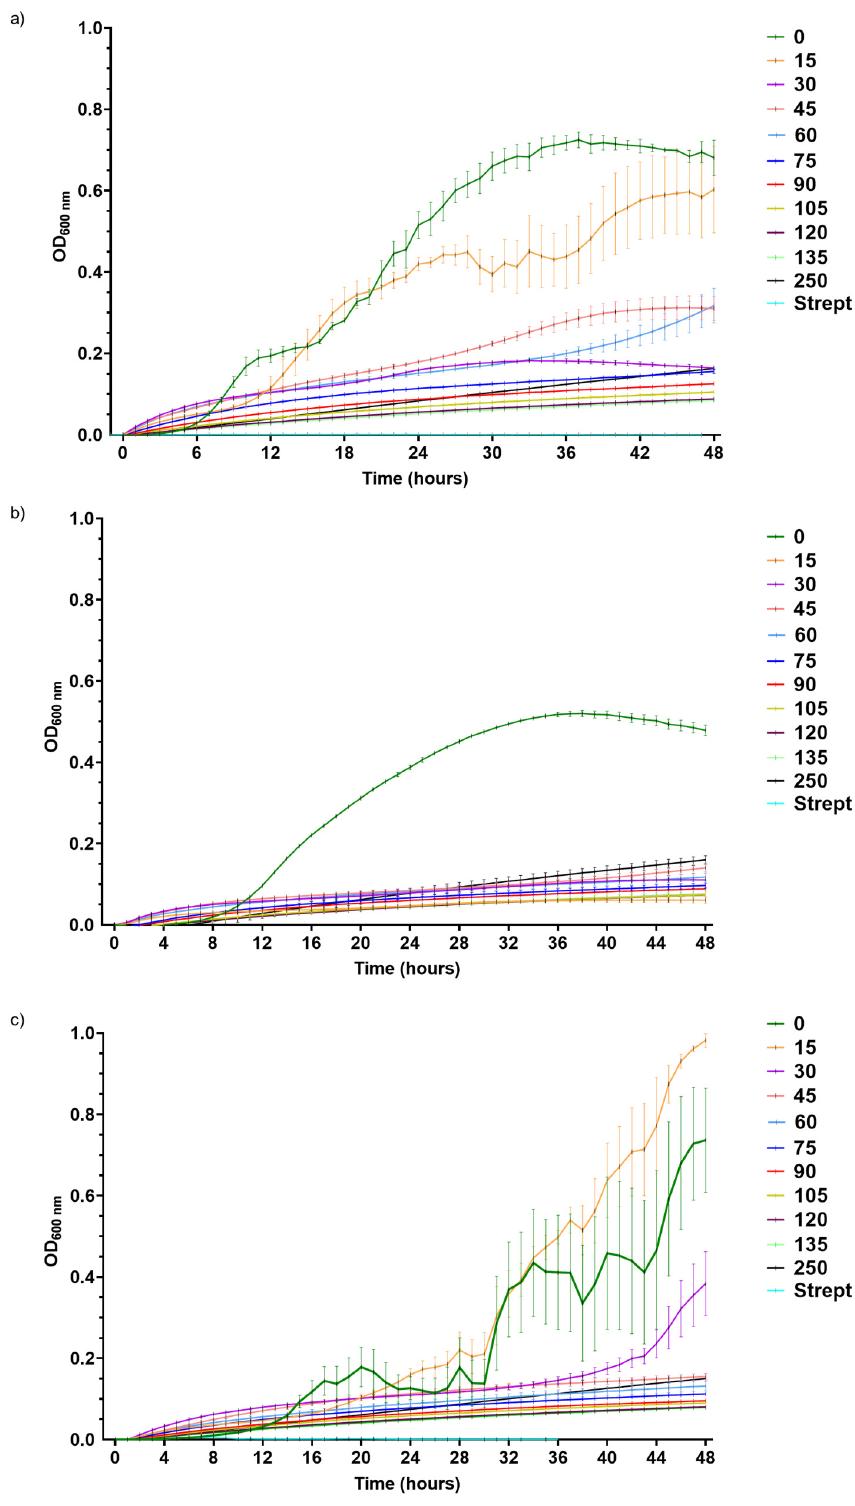
Figure 1. Growth curves of Pseudomonas syringae pv. tomato DC3000 ( a ), Xanthomonas euvesicatoria LMG 905 ( b ), and Clavibacter michiganensis michiganensis LMG 7333 ( c ) incubated for 48 h in different concentrations of the dried eucalyptus leaf extract (0, 15, 30, 45, 60, 75, 90, 105, 120, 135, and 250 g L − 1 ) prepared in MH medium. Streptomycin (Strept) was used as a control of growth inhibition (50 µg mL − 1 ). Each value indicates the average of three independent determinations.